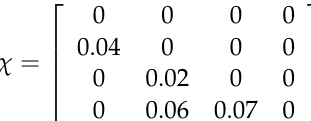
Figure 9. Failure chain model of the power transmission device.